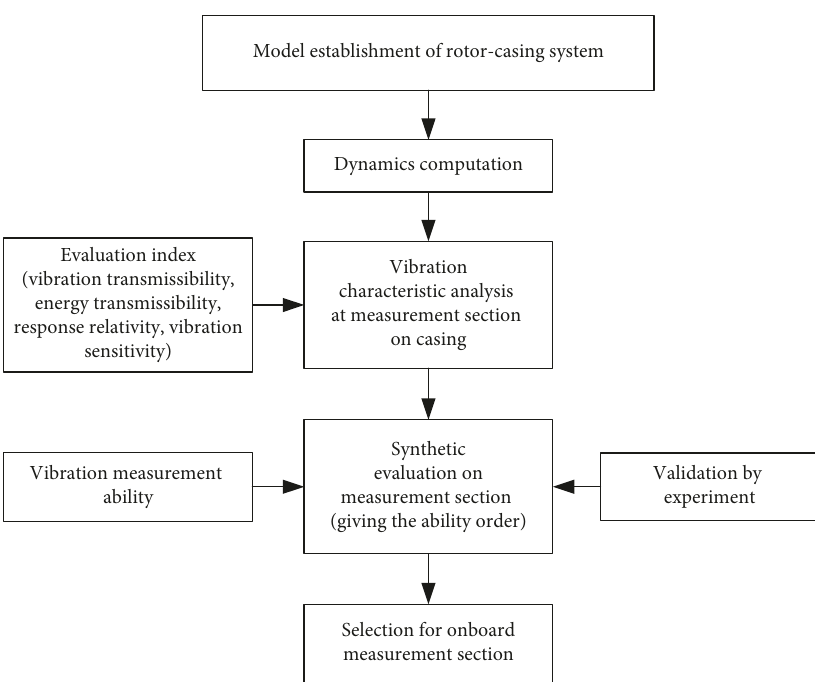
Figure 1: Flowchart of evaluation method for vibration measurement on